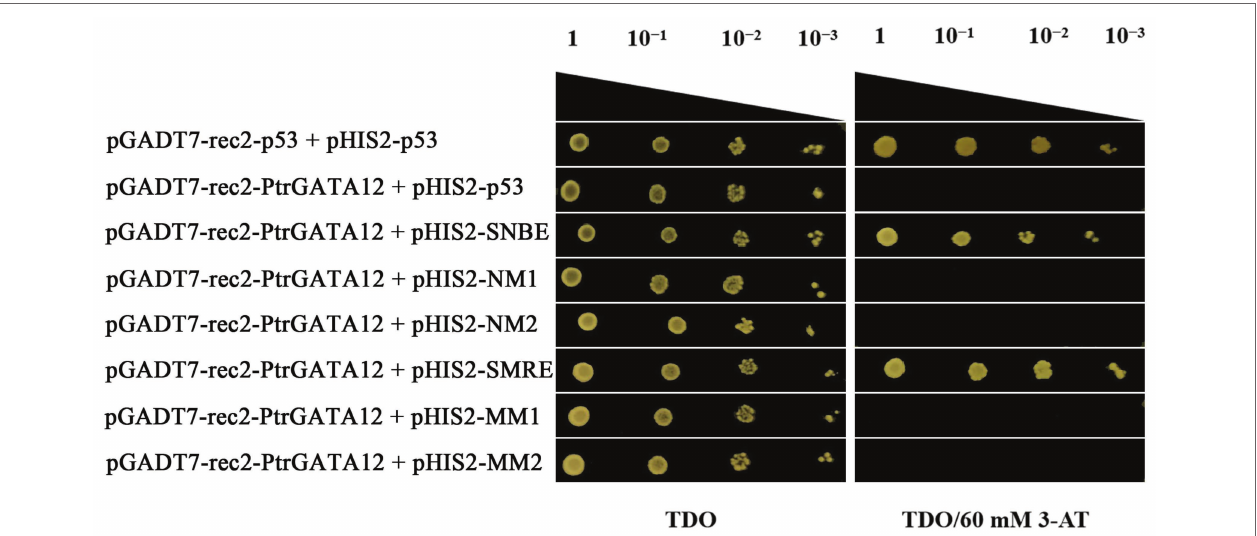
FIGURE 9 | Yeast one-hybrid assay of PtrGATA12 binding to cis -acting elements. The pGADT7-rec2-p53/pHIS2-p53 and pGADT7-rec2-PtrGATA12/pHIS2-p53 were used as the positive and negative control, respectively. 10 −1 , 10 −2 , and 10 −3 represent solution dilution ratio of transformed Y187 yeast